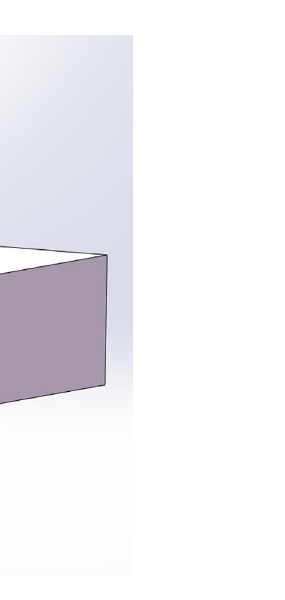
Fig 5. 3D rendering image of airflow tunnel and damper